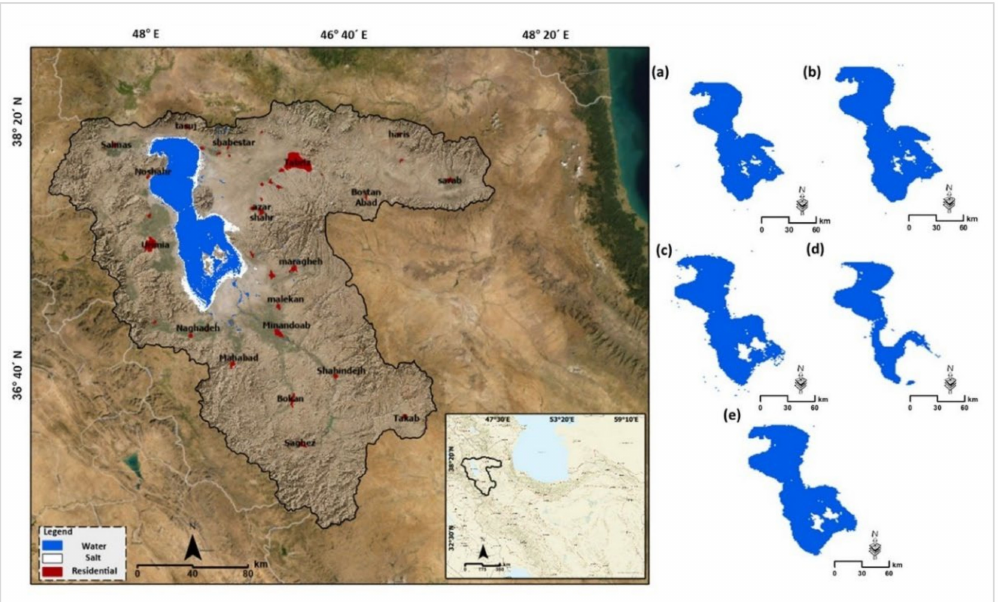
Figure 1. ULB location ( left ), and the Urmia Lake levels ( right ) in ( a ) 2000, ( b ) 2005, ( c ) 2010, ( d ) 2015, and ( e ) 2020.